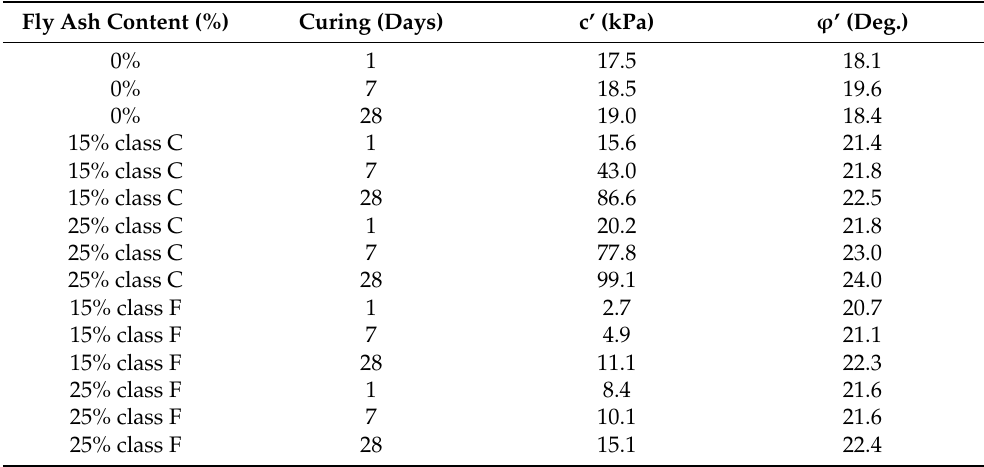
Table 4. Shear strength parameters of control and fly ash stabilized soil samples with different curing